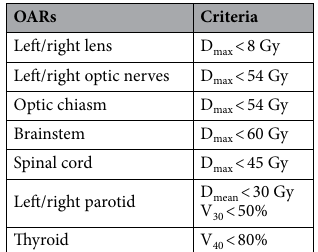
Table 2. The criteria of OAR for manual planning.